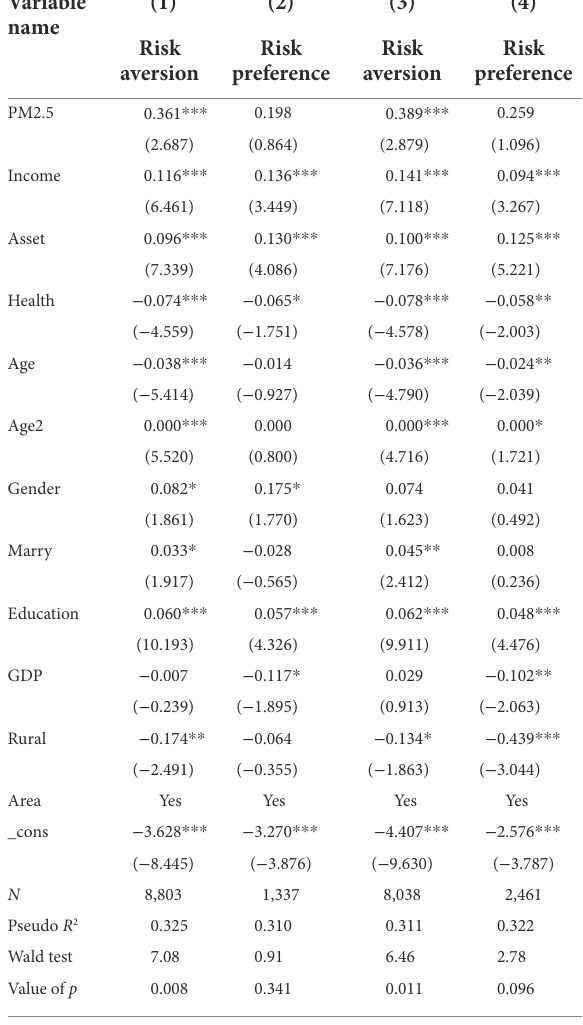
TABLE 9 Effect of haze pollution on family health care